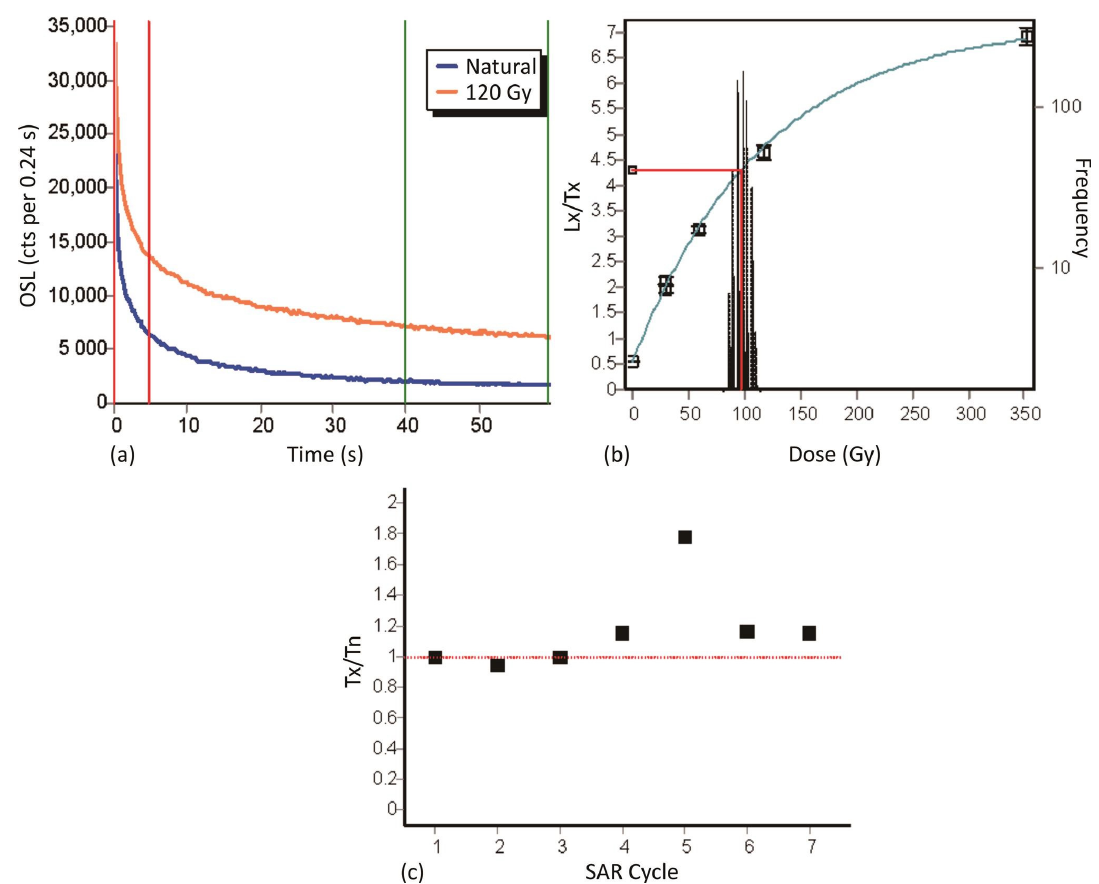
Figure 2. SAR analyses of the sample coded “MUS-1A” representing all samples. Exactly same analyses were performed for all samples ( a ) OSL shine-down of the sample for both natural and artificial doses. Initial 5 s used for integral and last 20 s for background ( b ) Dose response for the OSL signals of sample. The vertical left axes show the corrected OSL signal, the left axes Monte Carlo repeats of the calculated doses and the horizontal axes the laboratory radiation dose in Gy. The red dotted line also shows the ED. ( c ) Response to a testdose (Tx) normalized to the test dose response of the natural signal (Tn) throughout the measurements of sample showing the sensitivity changes occurring during the